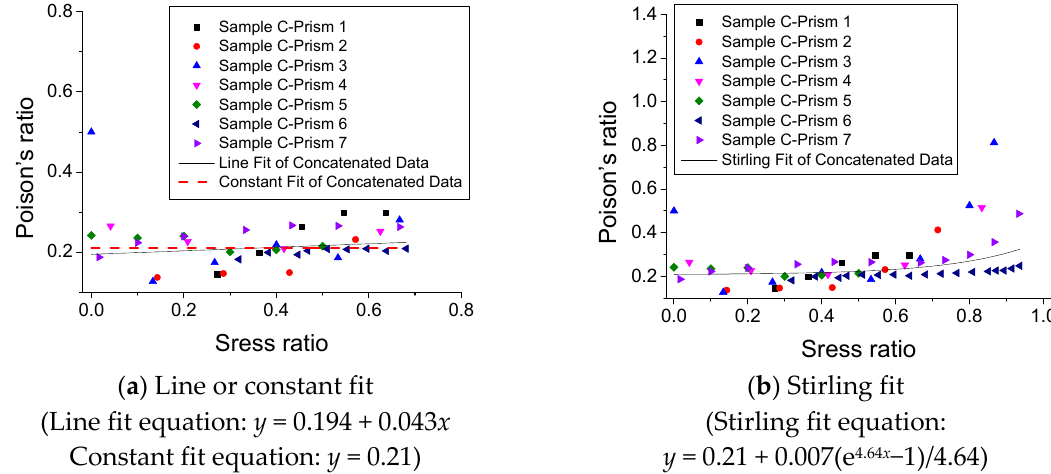
Figure 17. Fitting model and its predicted results of relationship of Poisson’s ratio - stress ratio ( υ v.s. σ / f c ). ( a ) Line or constant fit and ( b ) Stirling fit.